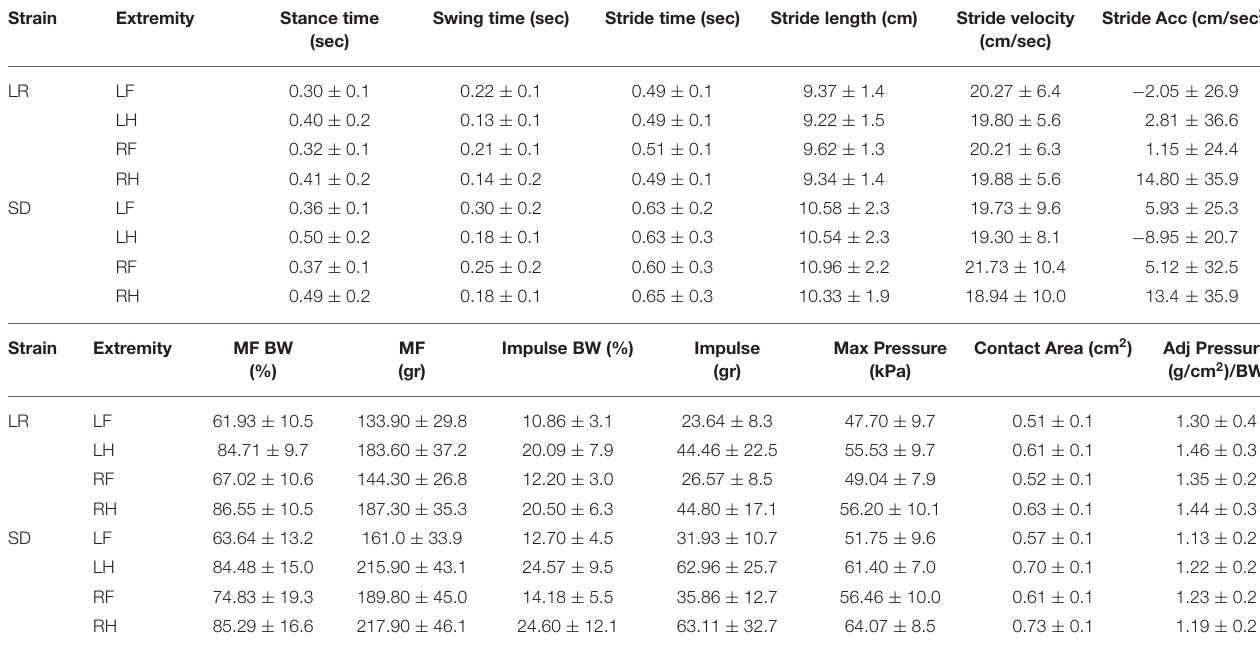
TABLE 3 | Values based on specific limbs for both